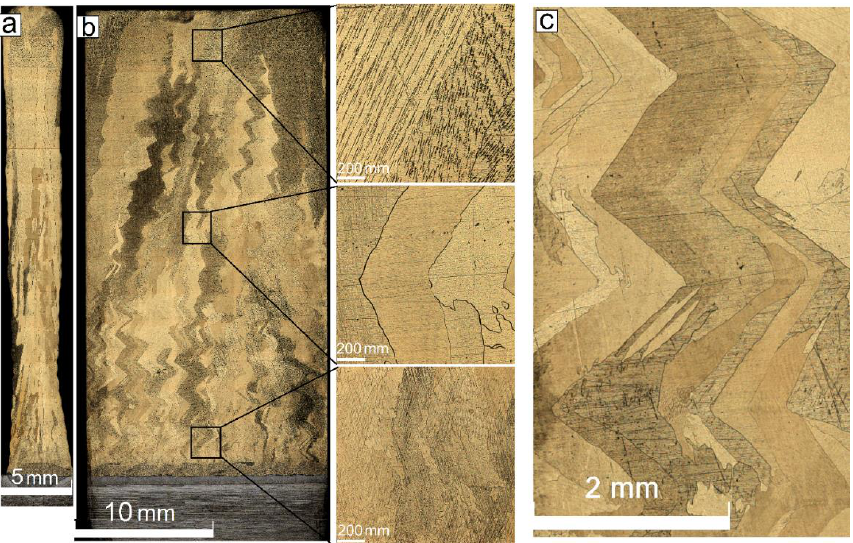
Figure 5. Profile ( a ) and front ( b , c ) cross section optical views of the Cu-7.5wt.%Al wall obtained at heat input of 0.255 kJ/mm. EBAM with heat input as high as 0.3 kJ/mm allowed obtaining a 28 mm height wall of thickness varying from 6.9 to 7.3 mm (Figure 6a). Only columnar grains with thick- nesses of 150 ± 50 μm, 450 ± 100 μm and 850 ± 125 μm as-measured in the bottom, half- height, and top parts of the wall, have been detected (Figure 6b).